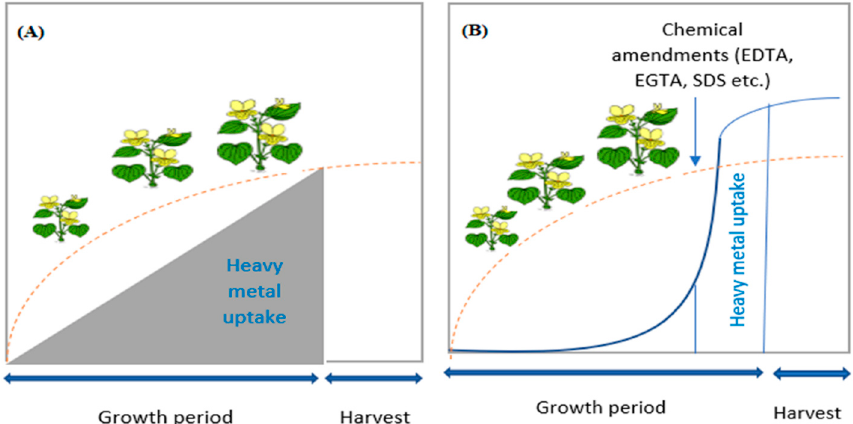
Figure 3. Chemical amendments assisting the heavy metal uptake in the plants, adapted from Souza et al. [43]. Figure ( A ) depicts that a hyperaccumulator plant accumulates the heavy metal gradually and constantly during the entire life cycle of the plant, whereas Figure ( B ) shows that the heavy metal behavior of a non-hyperaccumulator plant is relatively slow, but the metal uptake increases quickly after the application of chemical amendments along with